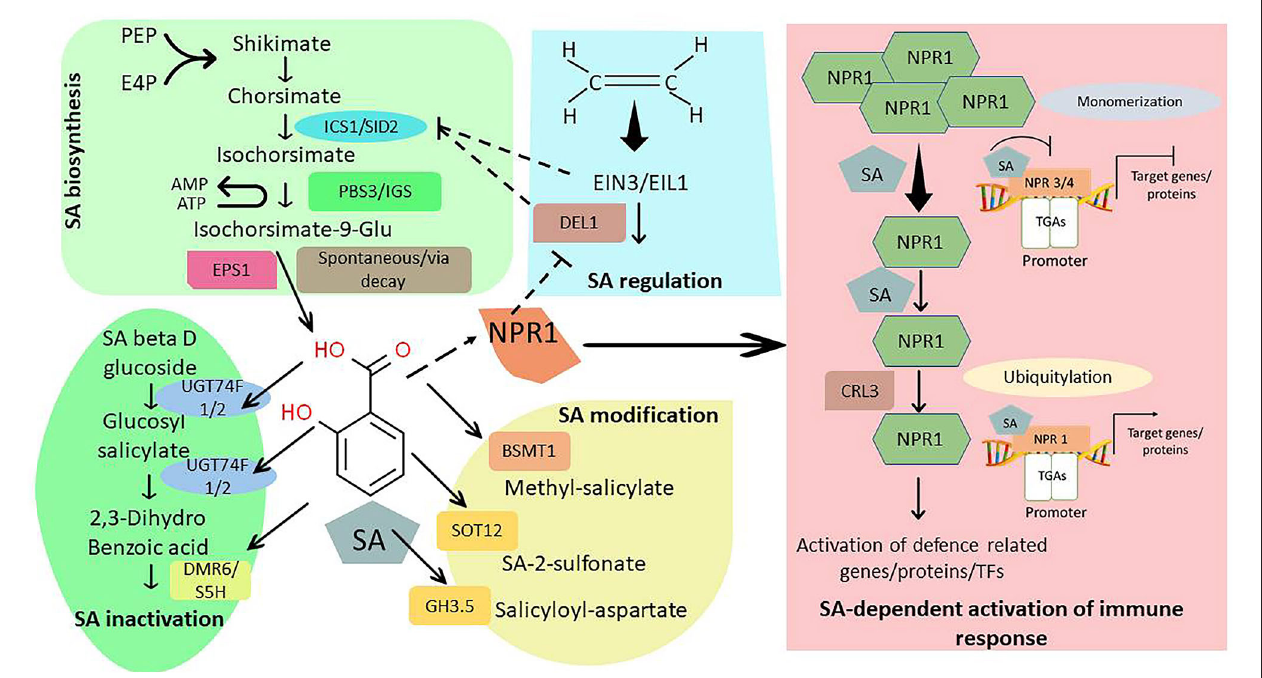
FIGURE 1 | An overview of salicylic acid (SA) synthesis, regulation and signaling in plants. The bioactive SA synthesis starts from shikimate catalyzed by isochorismate synthase (ICS1)/SA induction deficient 2 (SID2). Enhanced disease susceptibility 1 (EDS1) transfer isochorsimate from chloroplast to cytosol which is then converted into isochorsimate-9-glu by AVRPPHB susceptible 3 (PBS3) and isochorismoyl-glutamate synthase (IGS). The isochorsimate-9-glu finally yields SA either spontaneously or by activity of enhanced pseudomonas susceptibility 1 (EPS1). Higher accumulation of ethylene responsive genes such as ethylene insensitive 3 (EIN3) or EIN3 like 1 (EIL1) under the influence of DP-E2F-like1 (DEL1) transcription factor can inhibit transcriptional reprogramming of ICS1 and EDS5 thus inhibiting SA synthesis. However, at higher SA level the activity of EIN3 is repressed by NPR1. Overexpression of UDP-glucosyltransferase 74F1 and F2 (UGT74F1 and F2) along with downy mildew resistant 6/ salicylate-5-hydroxylase (DMR6/S5H) can result in the formation of inactivated SA like SA glucose ester. Similarly, BA/SA carboxyl methyltransferase 1 (BSMT1), sulfotransferase 1 (SOT12) and Gretchen Hagen 3.5 (GH3.5) can modify SA into different conjugates. SA mediated induction of immune response involves monomerization of non-expresser of pathogenic receptor 1 (NPR1) gene which upon higher SA accumulation interact and induce TGA transcription factors that activate 26S proteasome complex leading to ubiquitylation processing stimulated by Cullin-Ring ubiquitin E3 ligase